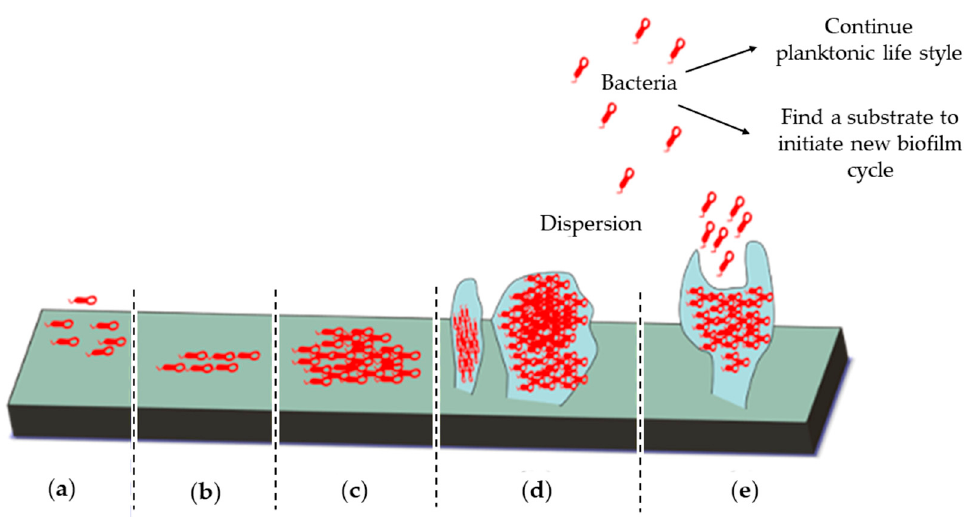
Figure 2. The five stages of biofilm formation. ( a ) Irreversible attachment of bacteria to a substrate, ( b ) bacterial proliferation, ( c ) shift from the bacterial planktonic to the biofilm life style by the loss of bacterial motility and production of extracellular polymeric substances (EPS), ( d ) biofilm maturation, and ( e ) dispersion of bacteria either to colonize a new substrate or shift to their original planktonic life style.